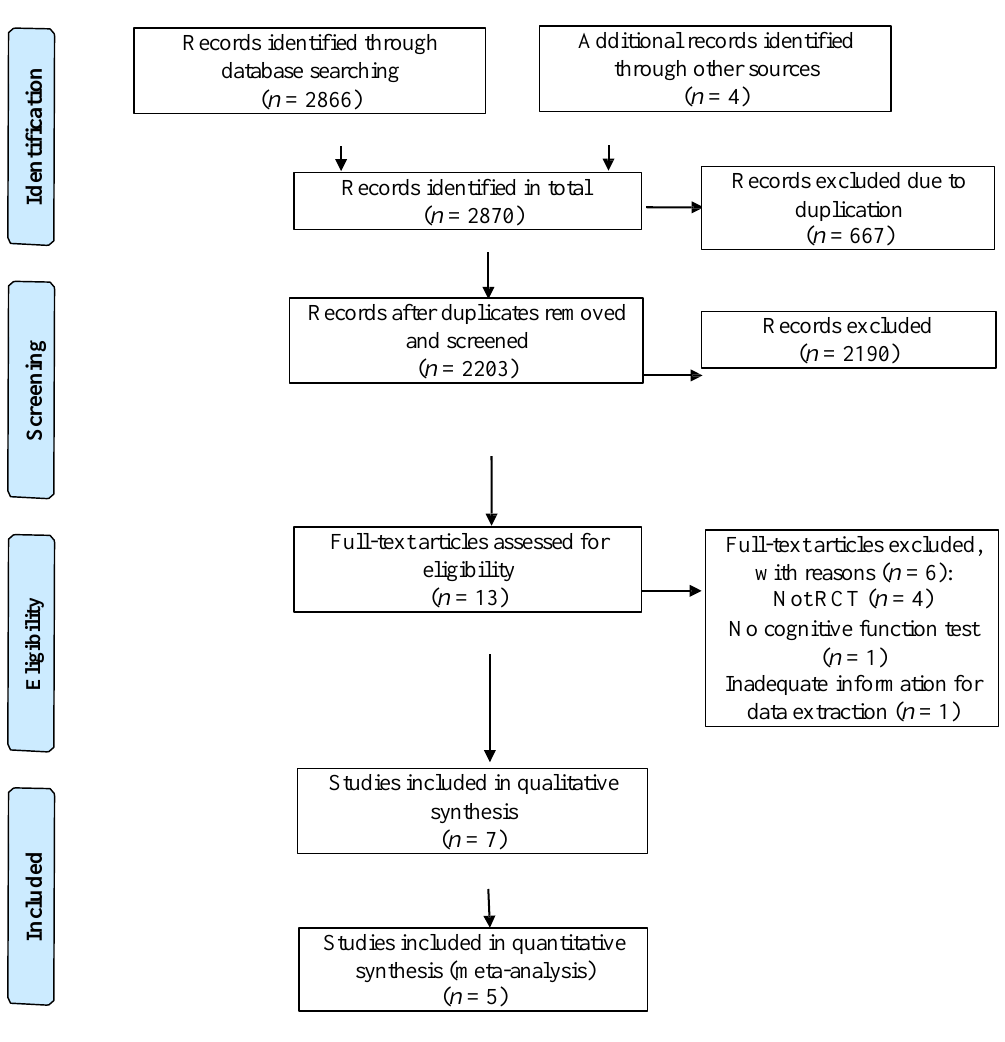
Figure 1. Flow of study selection.